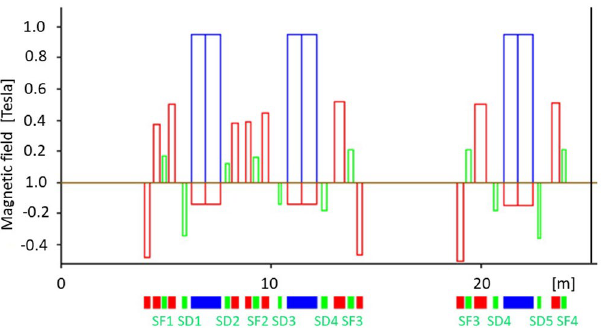
Figure 1. Magnetic fields of the first magnets in Fig. 2 are shown. In the lower part of the figure, the left set of magnets, separated by drift spaces, corresponds to a matching cell. The right set exhibits a half unit cell. The field strengths for the corresponding dipoles (blue), quadrupoles (red) and sextupoles (green) are depicted in the upper part of the figure. These field values are related with the parameters b n through Eq. (7).